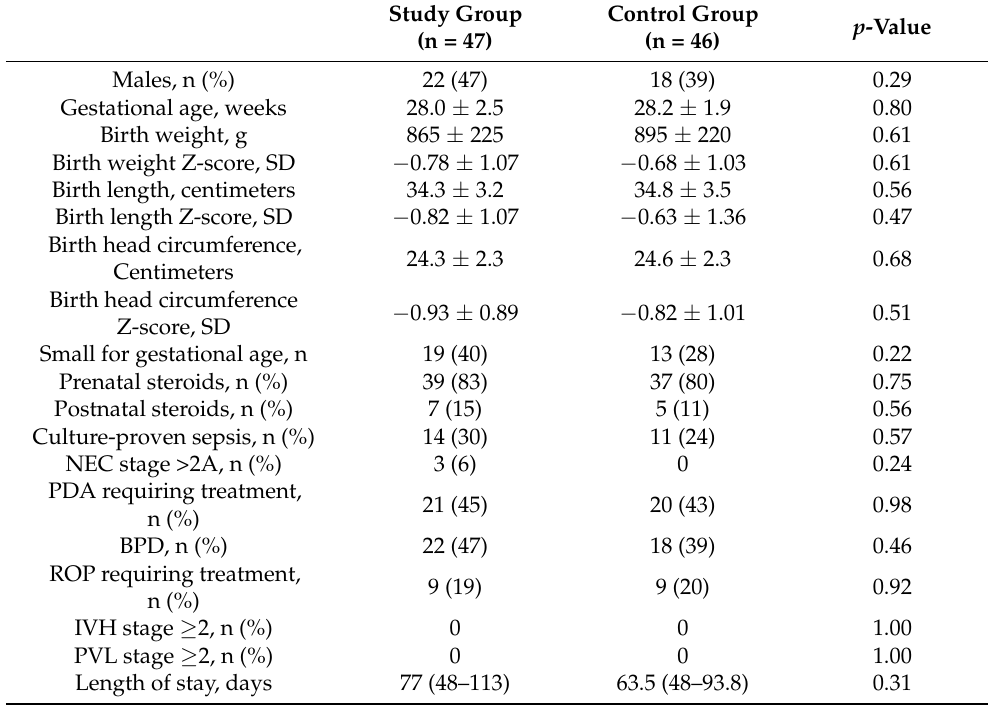
Table 1. Neonatal characteristics in the two groups.